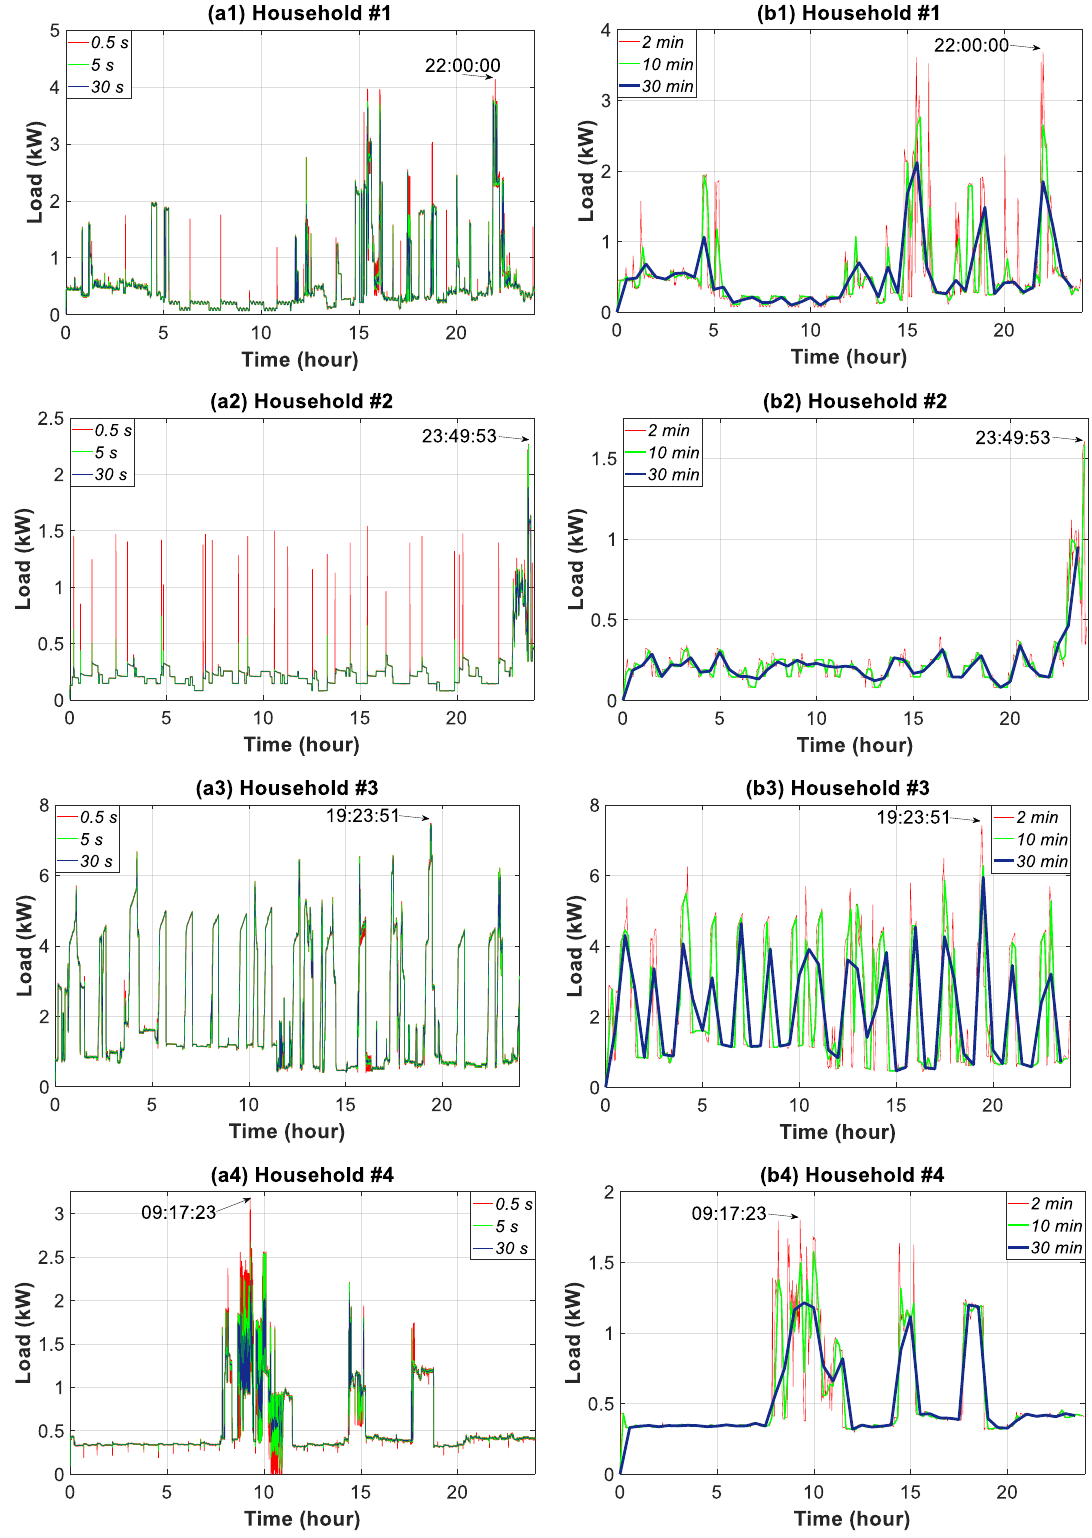
Figure 8. Daily consumption load profile for household #1 to #4: ( a1 – a4 ) 0.5 to 30 s granularities; ( b1 – b4 ) 2 to 30-min granularities.